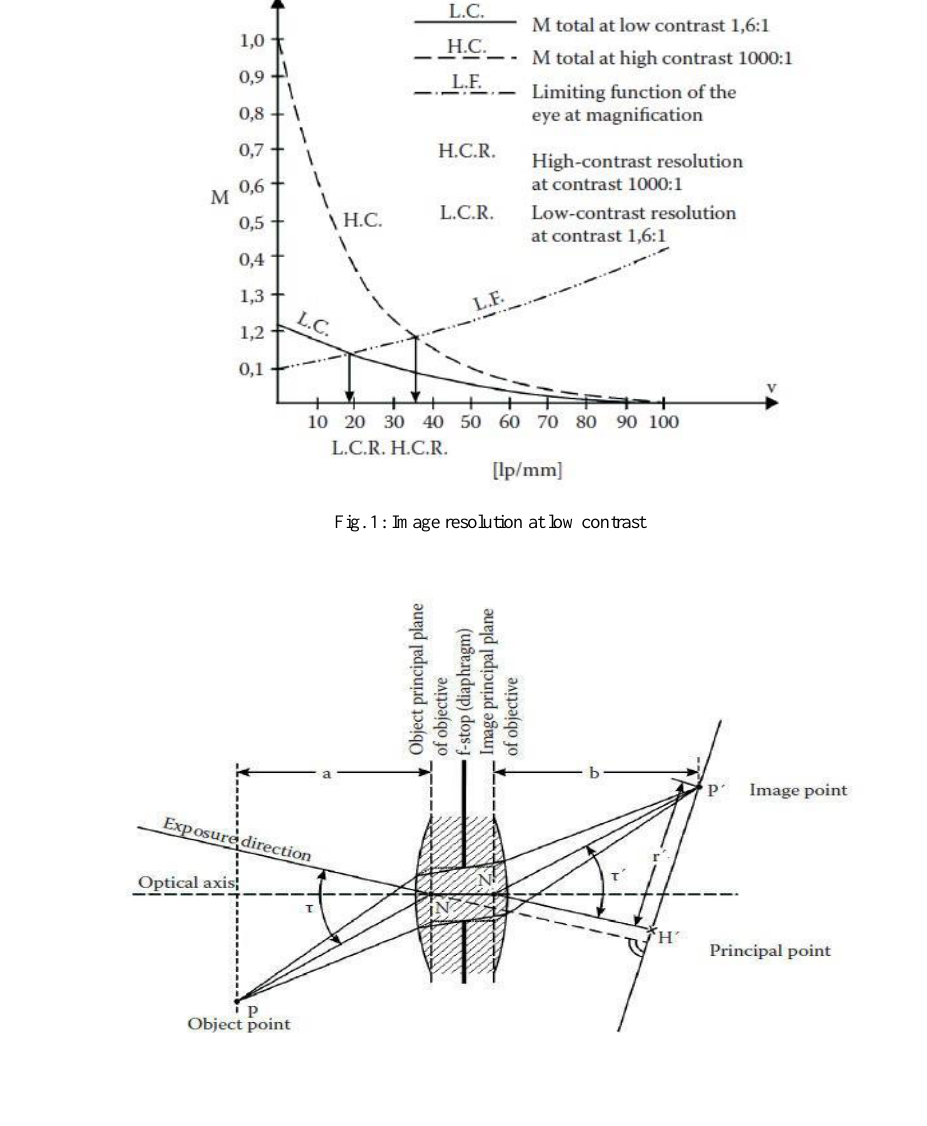
Fig. 2: Imaging through an